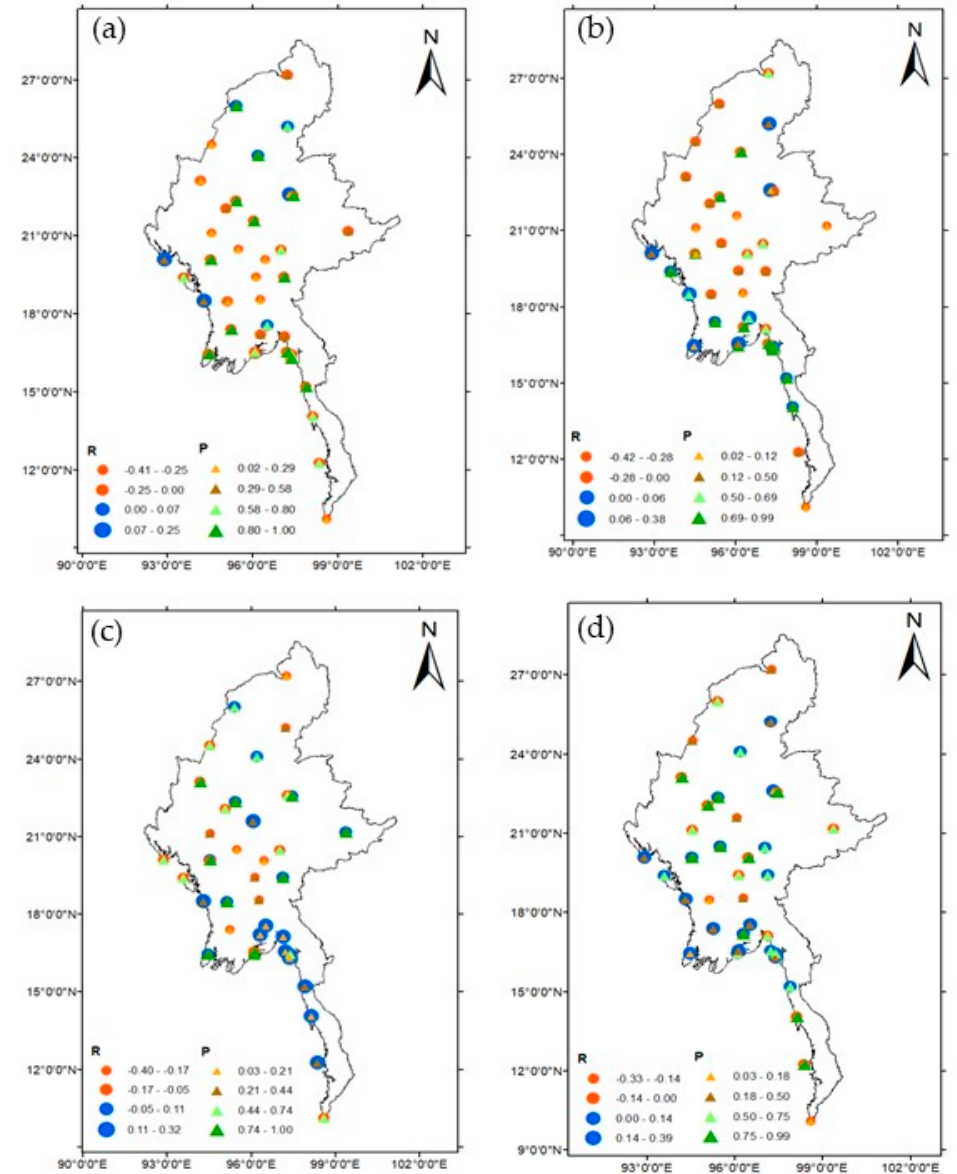
Figure 9. Spatial map of correlation between ENSO and ( a ) annual; ( b ) MJJ; ( c ) ASO; and ( d ) MJJASO SPEI from 1986 to 2015. The arrows denote areas where the tests were significant at the 5% level. The yellow arrow denotes no correlation; purple denotes weak correlation; the light green denotes moderate while the deep green denotes high correlation, respectively. The blue and red dots represent wet and dry, respectively.